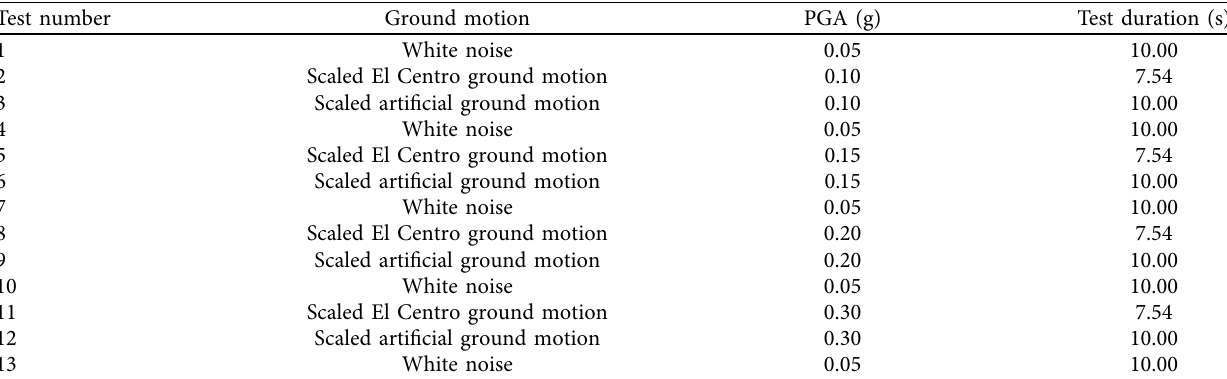
Figure 8: Acceleration time histories and response spectra of input ground motion. (a) El Centro ground motion. (b) Response spectrum of El Centro ground motion. (c) Artificial ground motion. (d) Response spectrum of artificial ground motion. Table 4: Loading conditions of shaking table tests.